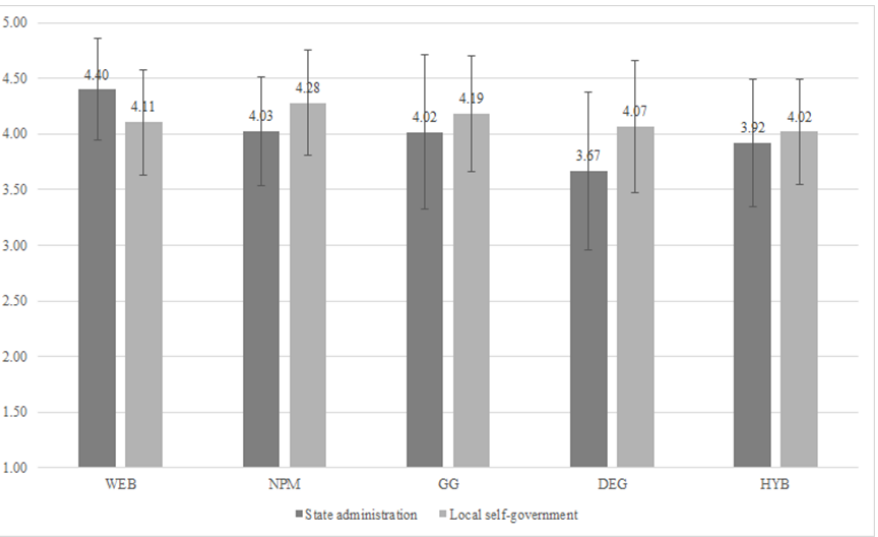
Figure 1. The presence of public governance models in selected segments of public administration.